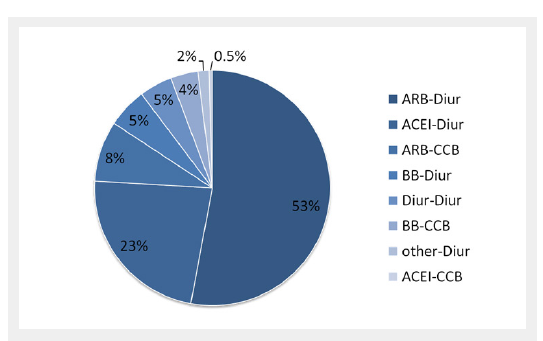
Composition of the different fixed combination therapies used in the study population. ACEI: angiotensin converting enzyme inhibitor; CCB: calcium channel blocker; ARB: angiotensin receptor blocker; Diur: diuretic; BB: betablocker; other: other antihypertensive